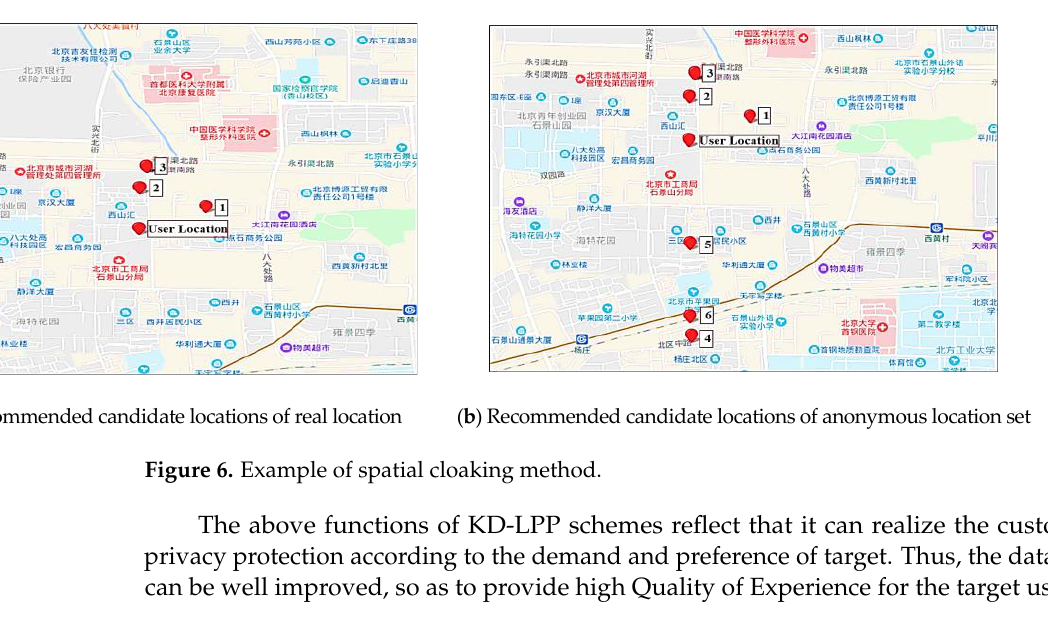
Figure 5. Example of KD-LPP scheme realization.